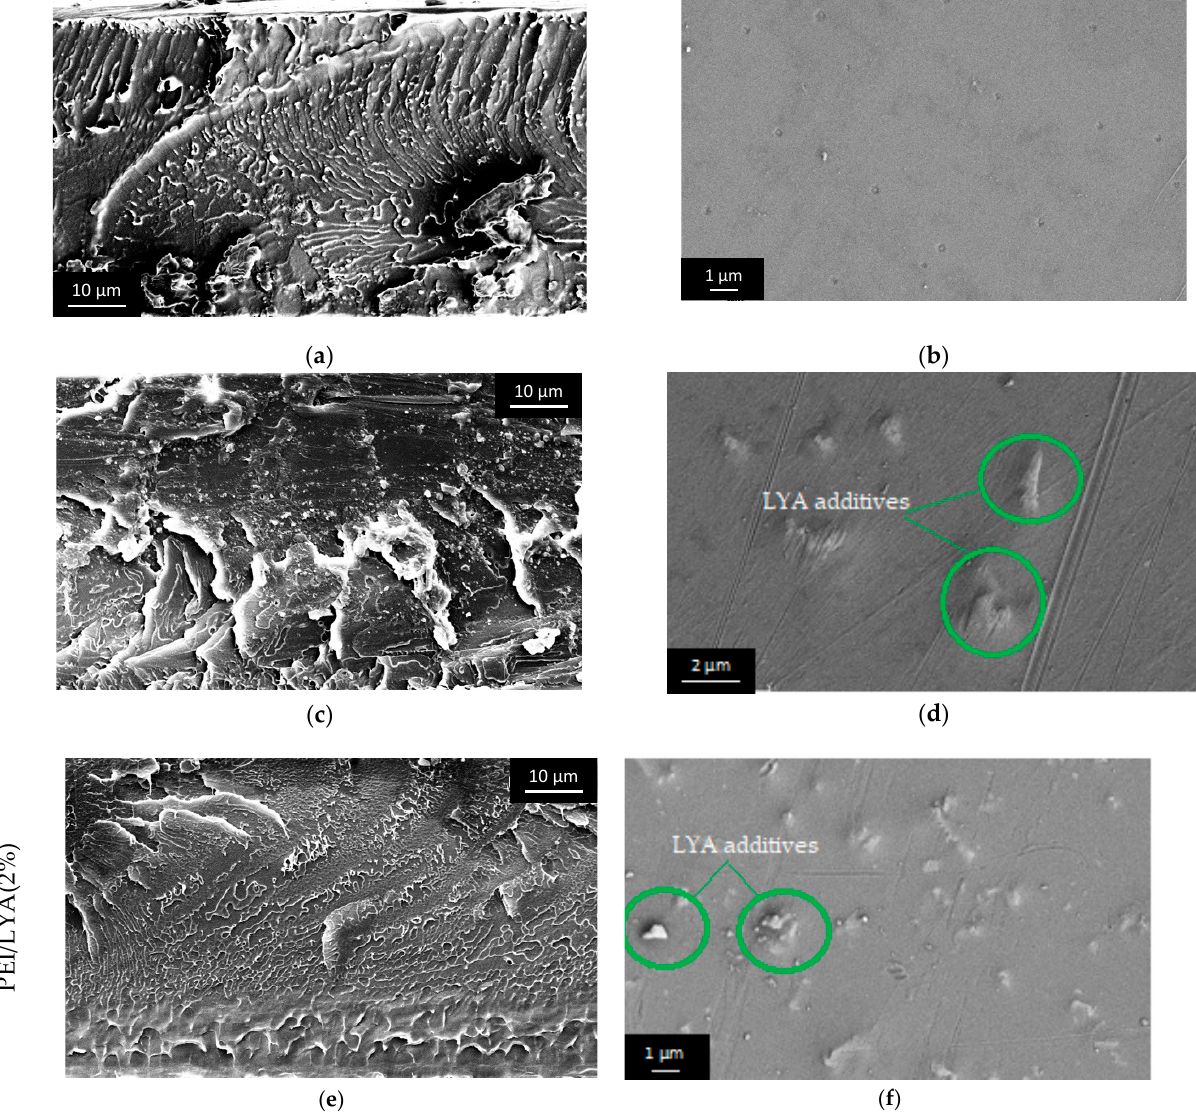
Figure 6. SEM micrographs of the ( a , c , e ) cross-section ( × 3000) and ( b , d , f ) bottom surface ( × 20,000) of the PEI/LYA membranes.